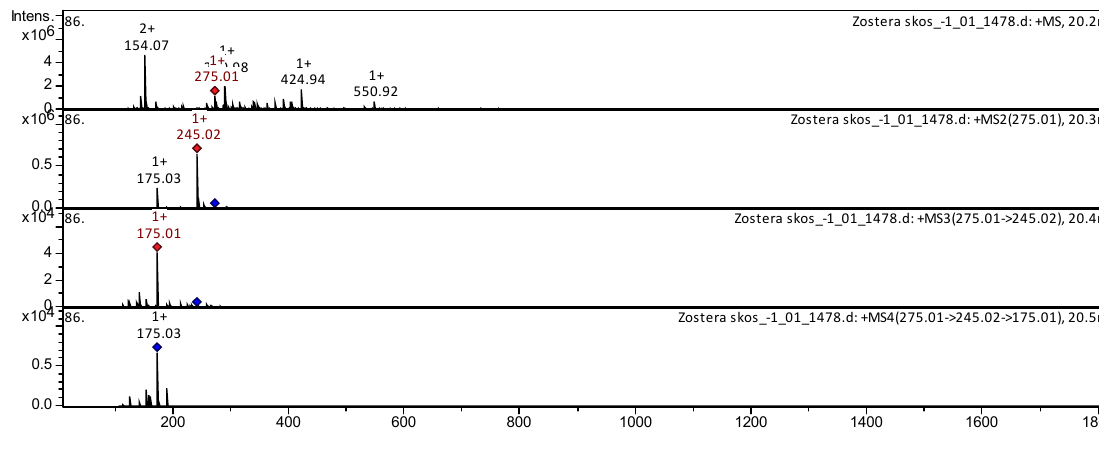
Figure 5. CID spectrum of (epi)Afzelechin from Z. marina , m/z 275.01. [M+H] + ion produced two fragment ions with m/z 245.02 and m/z 175.03 (Figure 5). The fragment ion with m/z 245.02 produced one characteristic daughter ion with m/z 175.01. It was identified in the references in extract from Cassia granidis [7] ; Cassia abbreviata [8]; A. cordifolia; F. glaucescens; F. herrerae [9] . It should be noted separately that the pres- ence of many sulfated polyphenols was found in the supercritical extracts of Z. marina . 7-sulfate, Kaempferol 7-sulfate, Isorhamnetin 3-sulfate, Apigenin7-sulfate, Chrysoeriol 7- sulfate, Luteolin 7,3 ′ -disulfate, (2S)-Naringenin 4’- O -sulfate. The CID spectrum in positive ion modes of flavone Luteolin 7-sulfate from Z. marina is shown in Figure 6.